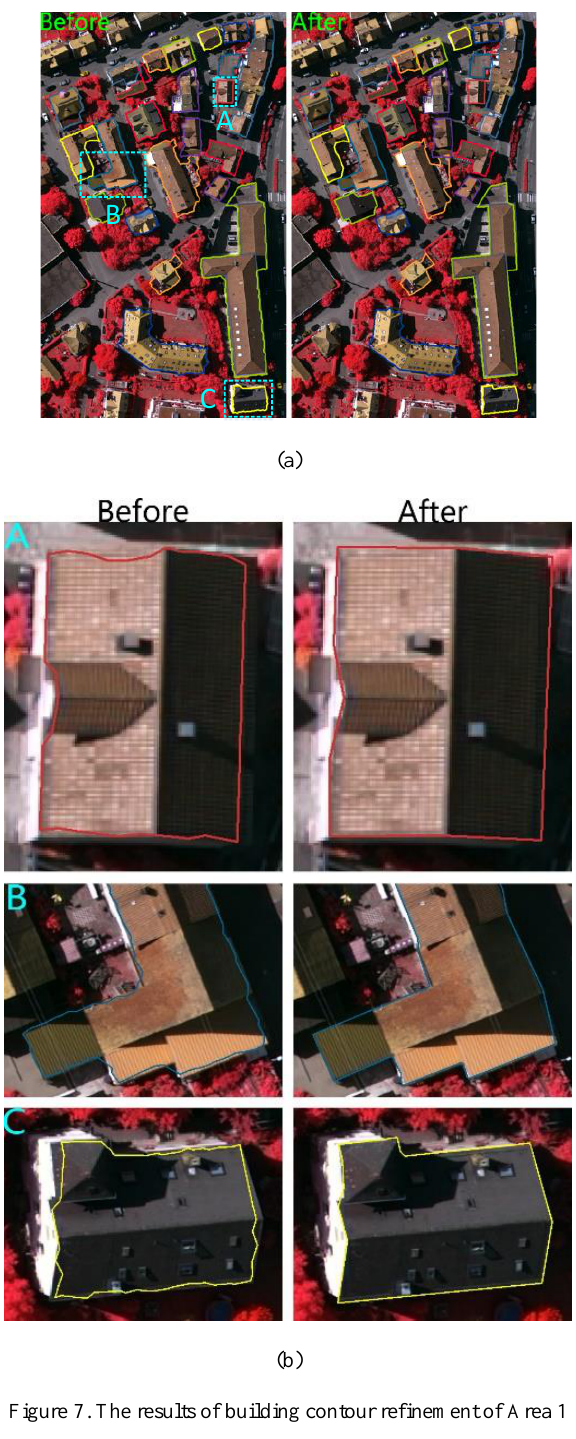
Figure 7. The results of building contour refinement of Area 1